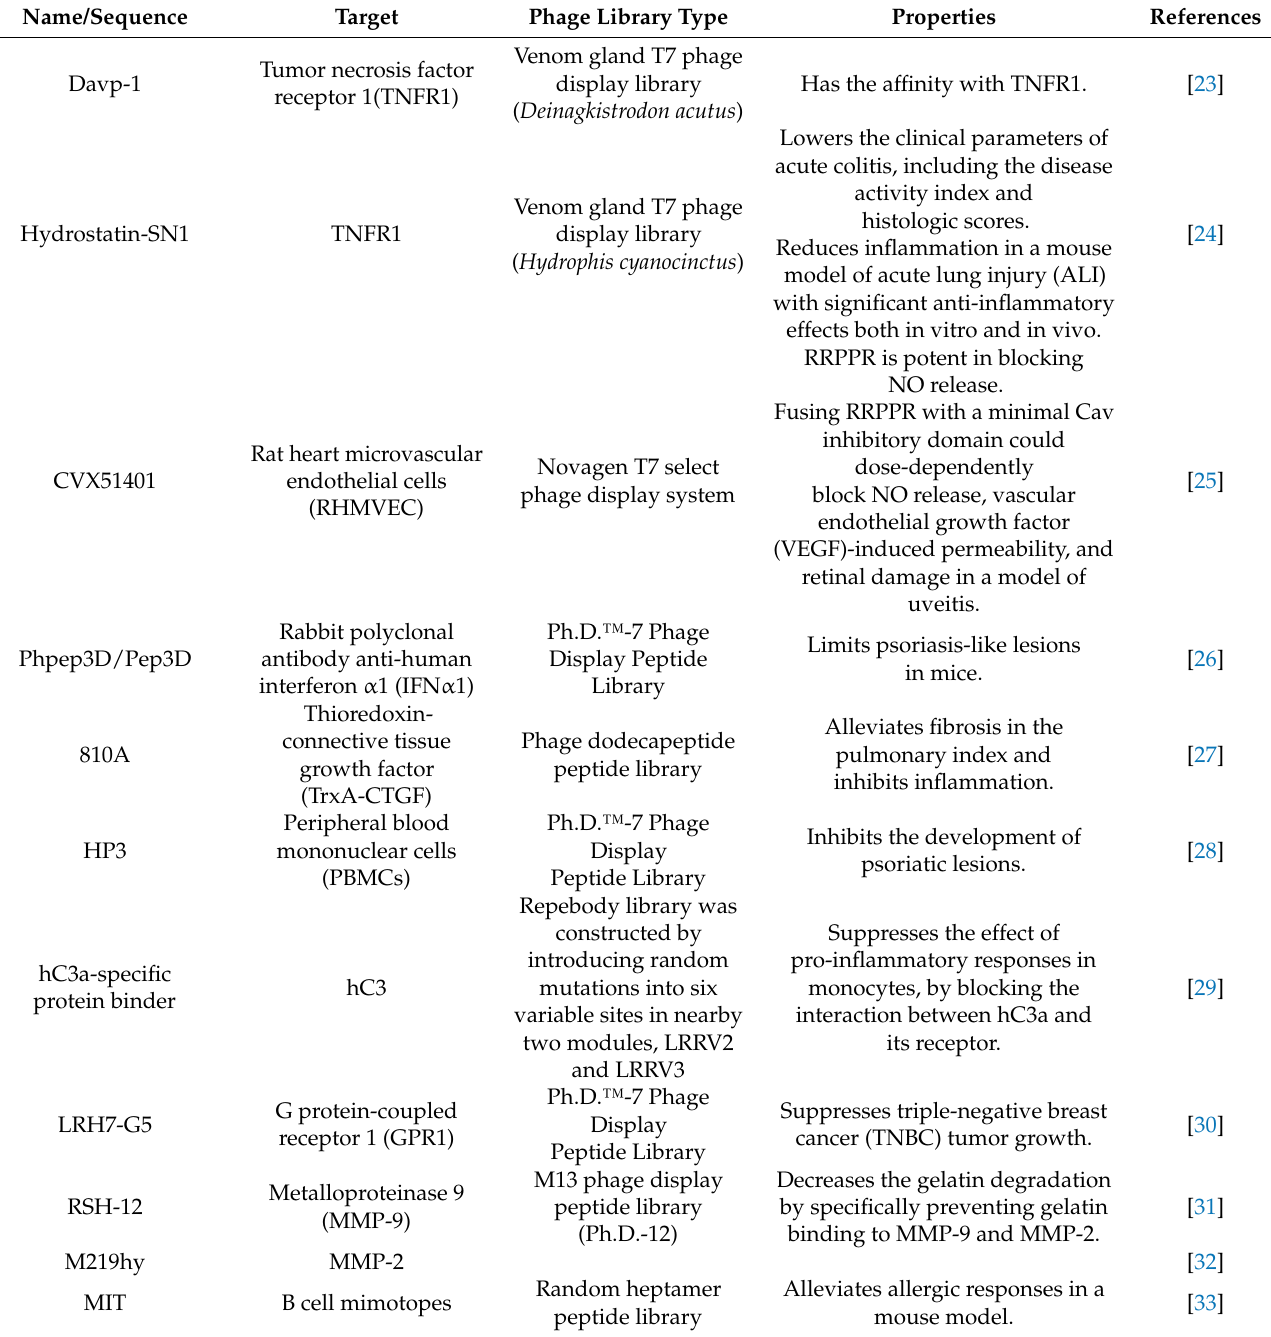
Table 1. The peptides screened for anti-inflammation properties in recent